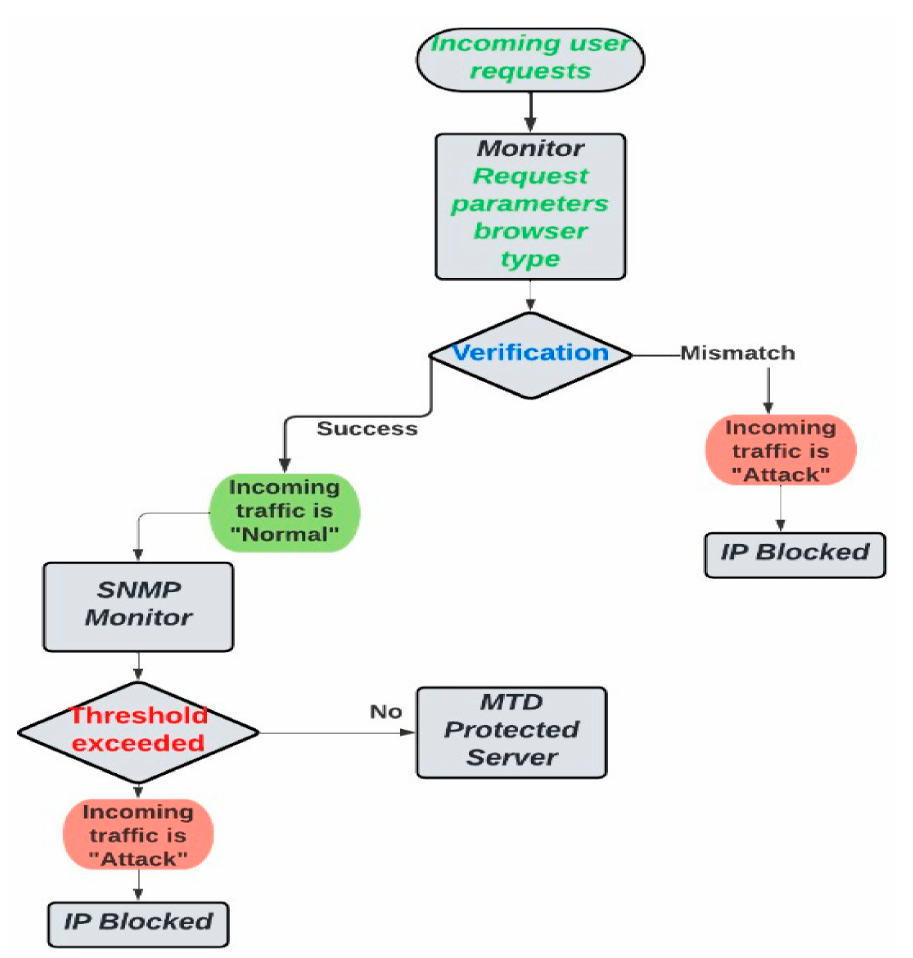
Figure 8. Overall DDoS detection using SNMP, mitigation using